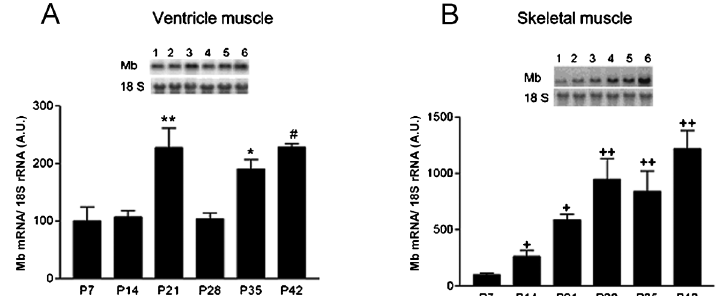
Figure 1. Pattern of Mb mRNA expression in ventricular and skeletal muscles of rats through- out the postnatal developmental period. Northern blot analysis of ventricular and skeletal Mb mRNA levels of intact rats from postnatal (P) day 7 through P42 is shown at the top of the figure, and the quantitative results obtained by densitometric analysis of Mb and 18s rRNA transcripts hybrid- ization ratio are shown at the bottom, in arbitrary units (A.U.). Data are reported as means±SE of 12 animals/group. *P , 0.05 and **P , 0.01 vs P7, P14, and P28; # P , 0.01 vs all groups except P21; + P , 0.01 vs all groups; ++ P , 0.05 vs P7, P14, and P21 (one-way